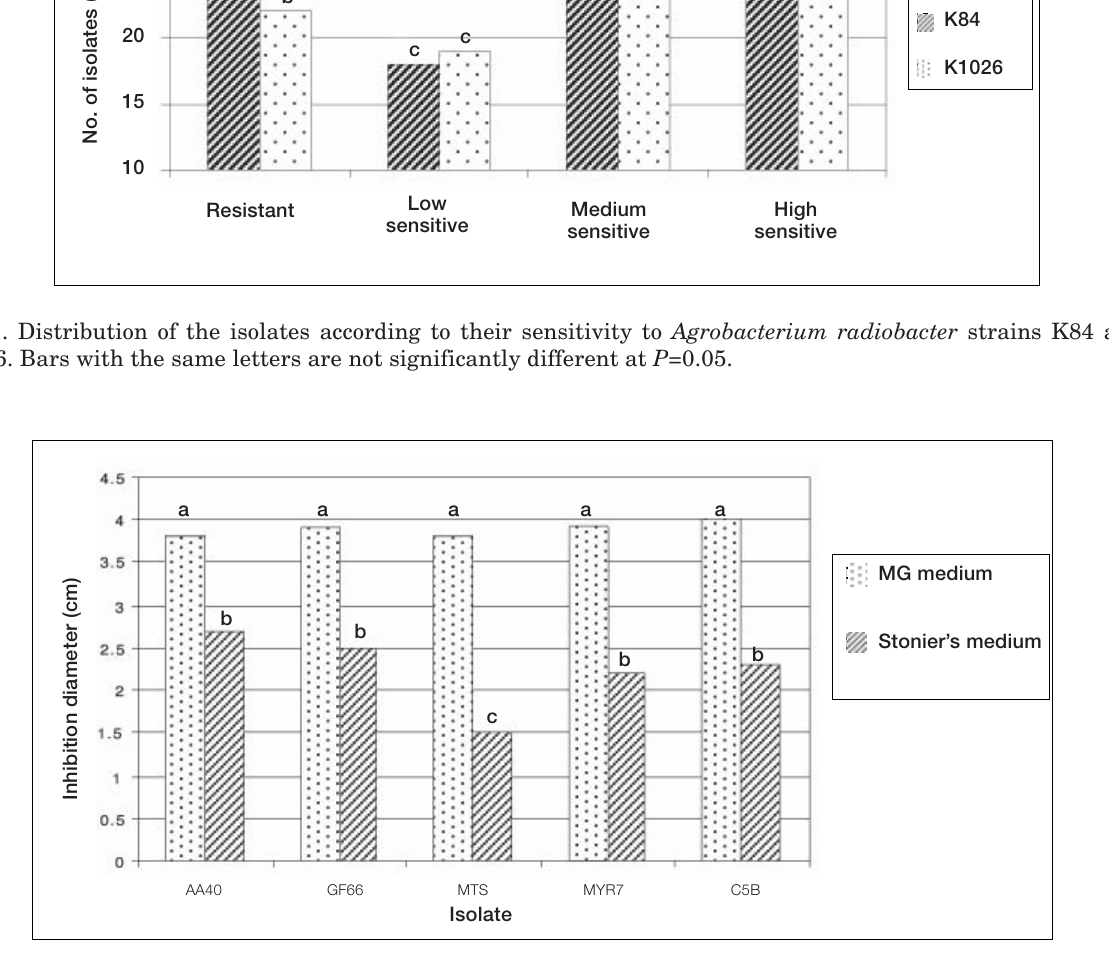
Fig. 2. Inhibition diameter on MG and Stonier’s media for some Agrobacterium tumefaciens isolates sensitive to A. radiobacter strain K84. Bars with the same letter are not significantly different at P